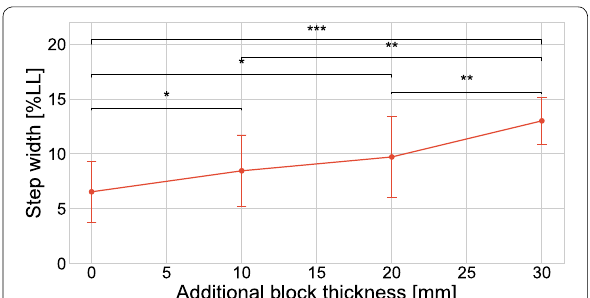
Fig. 11 Additional block thickness and step width. With increasing the block thickness, step width increased. Single stars (*), twin stars (**) and triple stars (***) represent results of the paired t-test ( P < 0.05 , P < 0.01 and P < 0.001 , respectively). These error bars represented standard deviation of means dominated by inter-participant variability